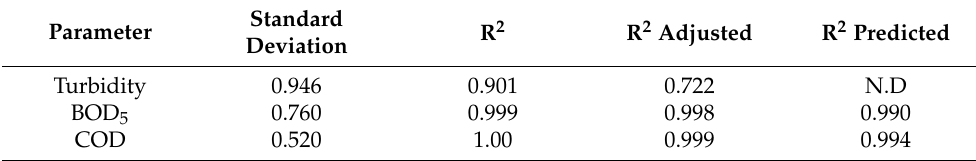
Table 5. Statistical analysis of the regression coefficients estimated due to the FW variation. Parameter